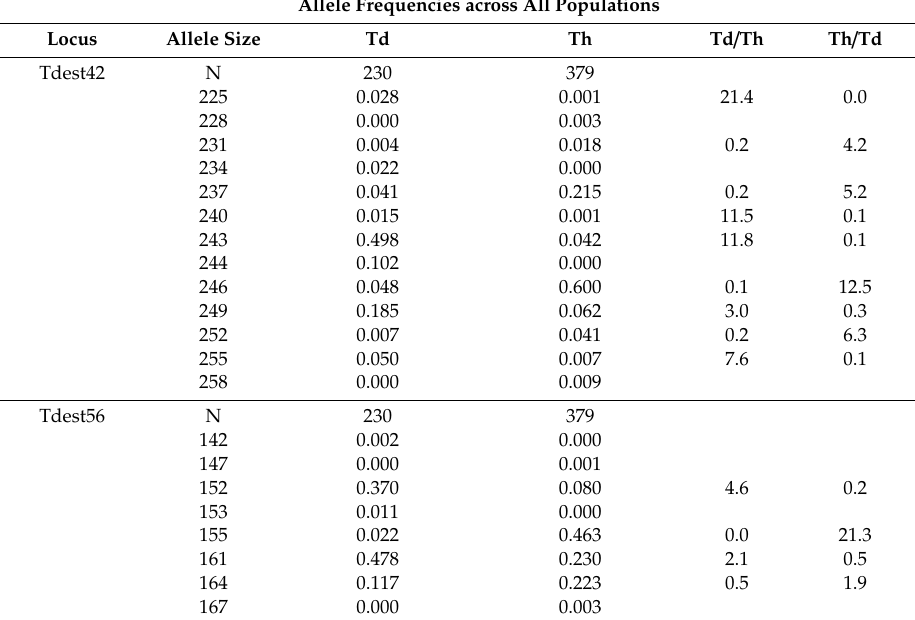
Table A3. Cont. Allele Frequencies across All